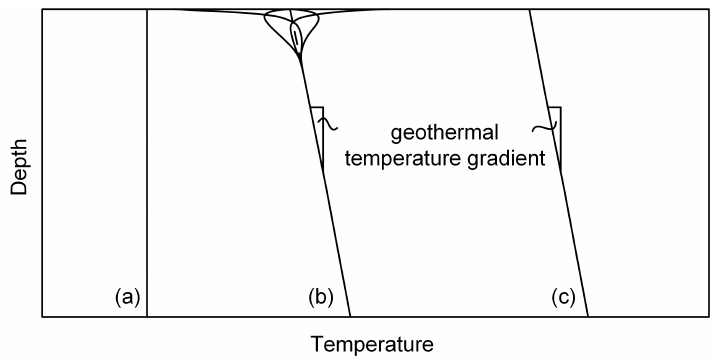
Figure 5. Schematic representation of the different temperature boundary conditions for BTES and pipe network: ( a ) constant temperature, ( b ) TRY data set and geothermal temperature gradient, ( c ) geothermal temperature